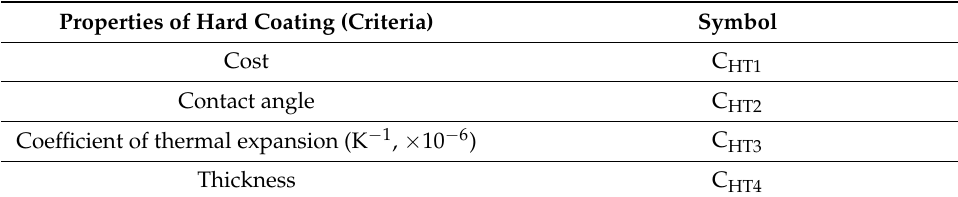
Table 13. Evaluation criteria of coating materials.